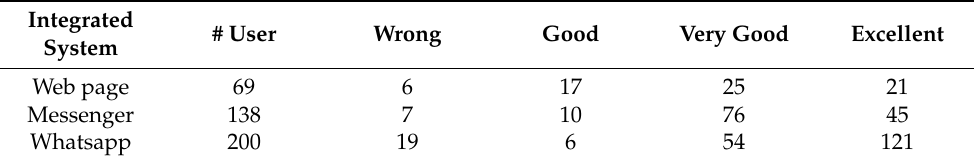
Table 5. Results obtained from a Chatbot applied with the proposed